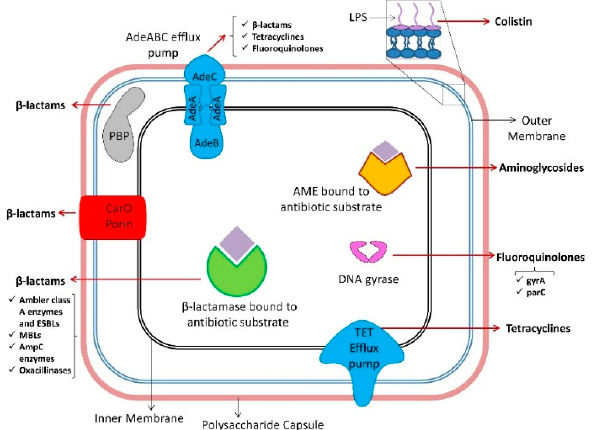
Figure 3. Diagram of various resistance mechanisms of Acinetobacter baumannii to antimicrobial agents. Antibiotic modifying enzymes, efflux pumps, porins, drug targets, and the affected antibiotics by each resistance mechanism are shown. AMEs = Aminoglycoside modifying enzymes; AmpC = Ambler class C cephalosporinases; ESBLs = Extended-spectrum β -lactamases; MBLs = Metallo- β -lactamases; LPS = Lipopolysaccharide; PBP = Penicillin binding protein.